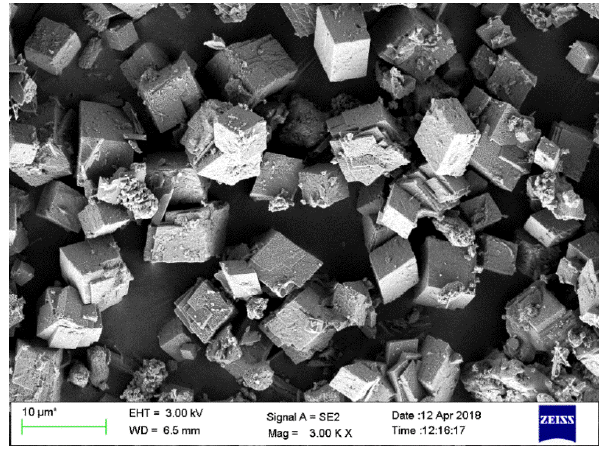
Figure 2. Field emission scanning electron micrograph (FESEM) of the calcite phase of calcium carbonate microparticles from incense sticks ash.